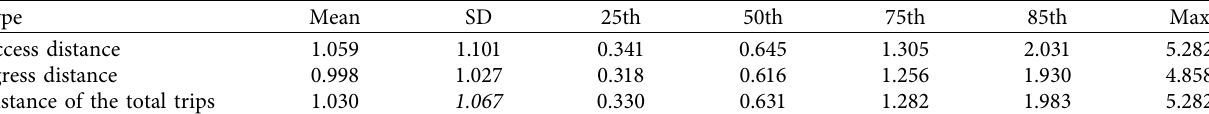
Table 4: Descriptive statistics of distance (unit: km).